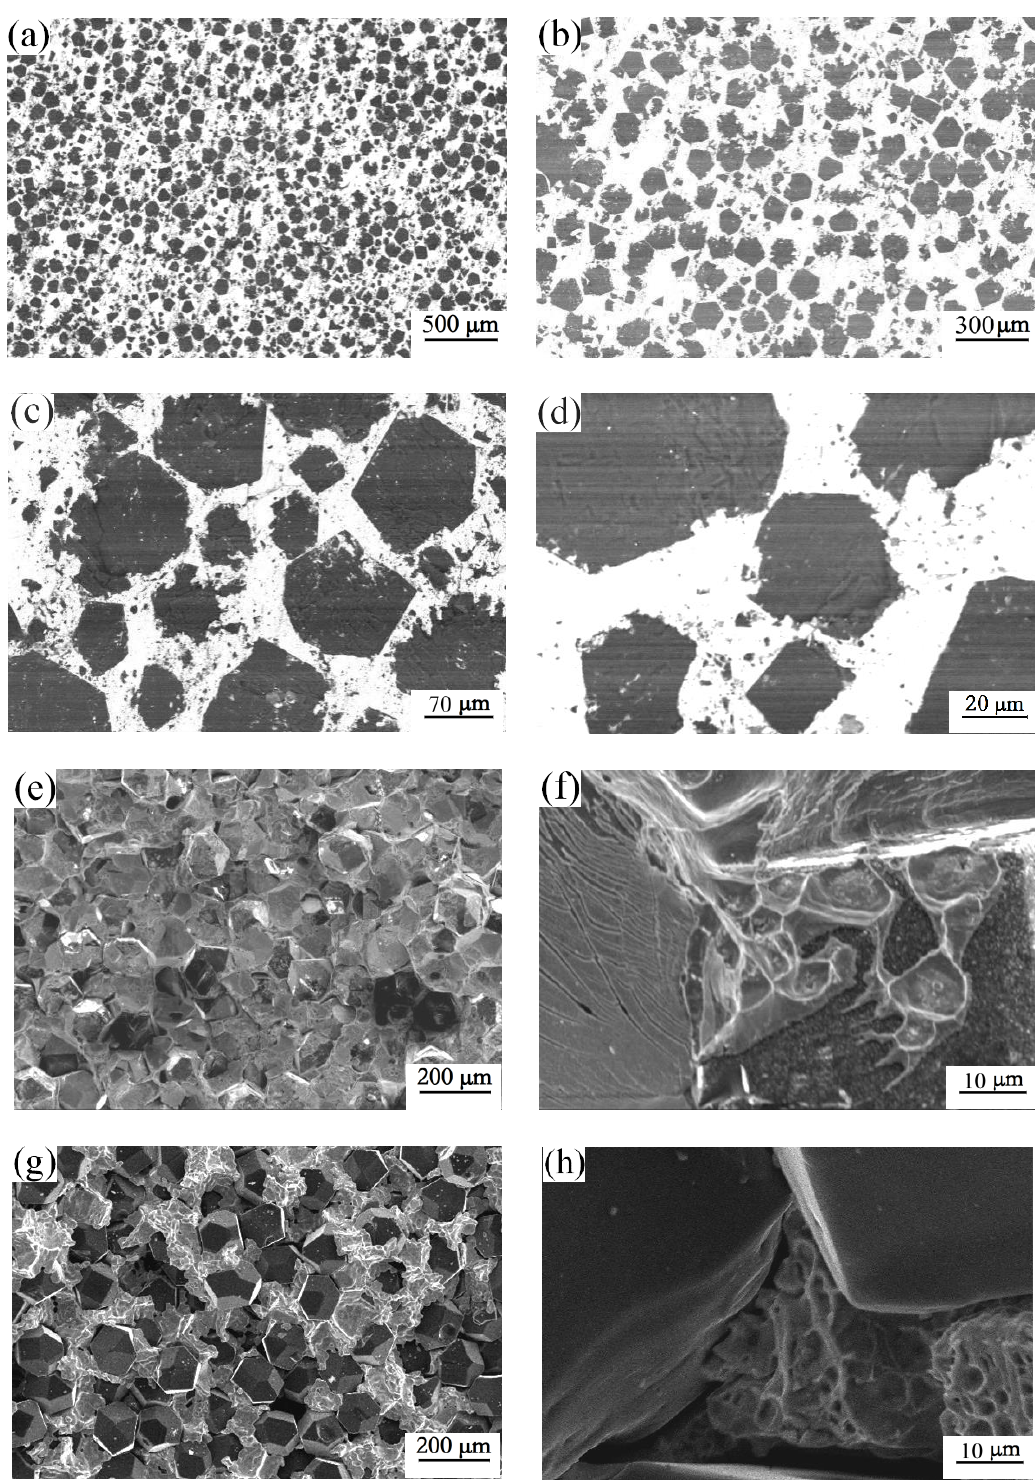
Figure 4. Micro-morphology of diamond-copper composites: ( a – d ) the polished surface of the composites; ( e , f ) fracture surface of ZrC/Zr-coated diamond-copper composites; ( g , h ) fracture surface of uncoated diamond-copper composites.